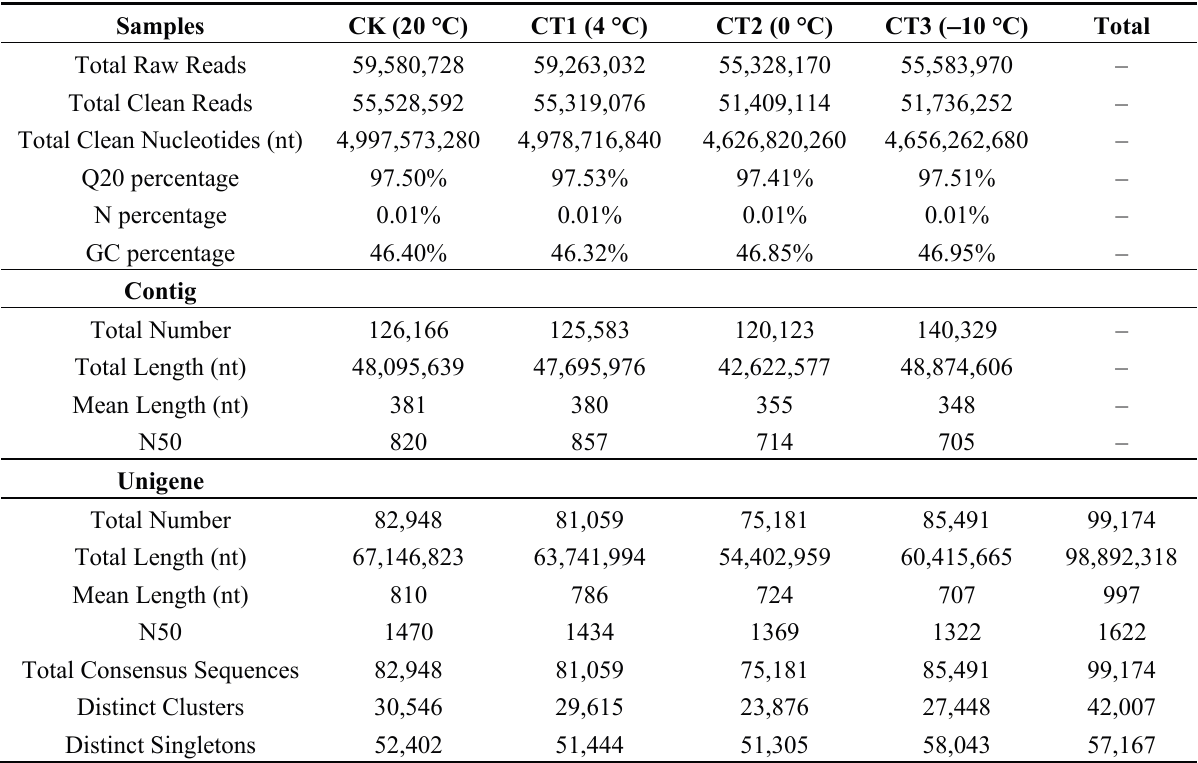
Table 1. Statistics of the sequencing and assembly of cold-treated (CT) and control (CK) Phlox subulata